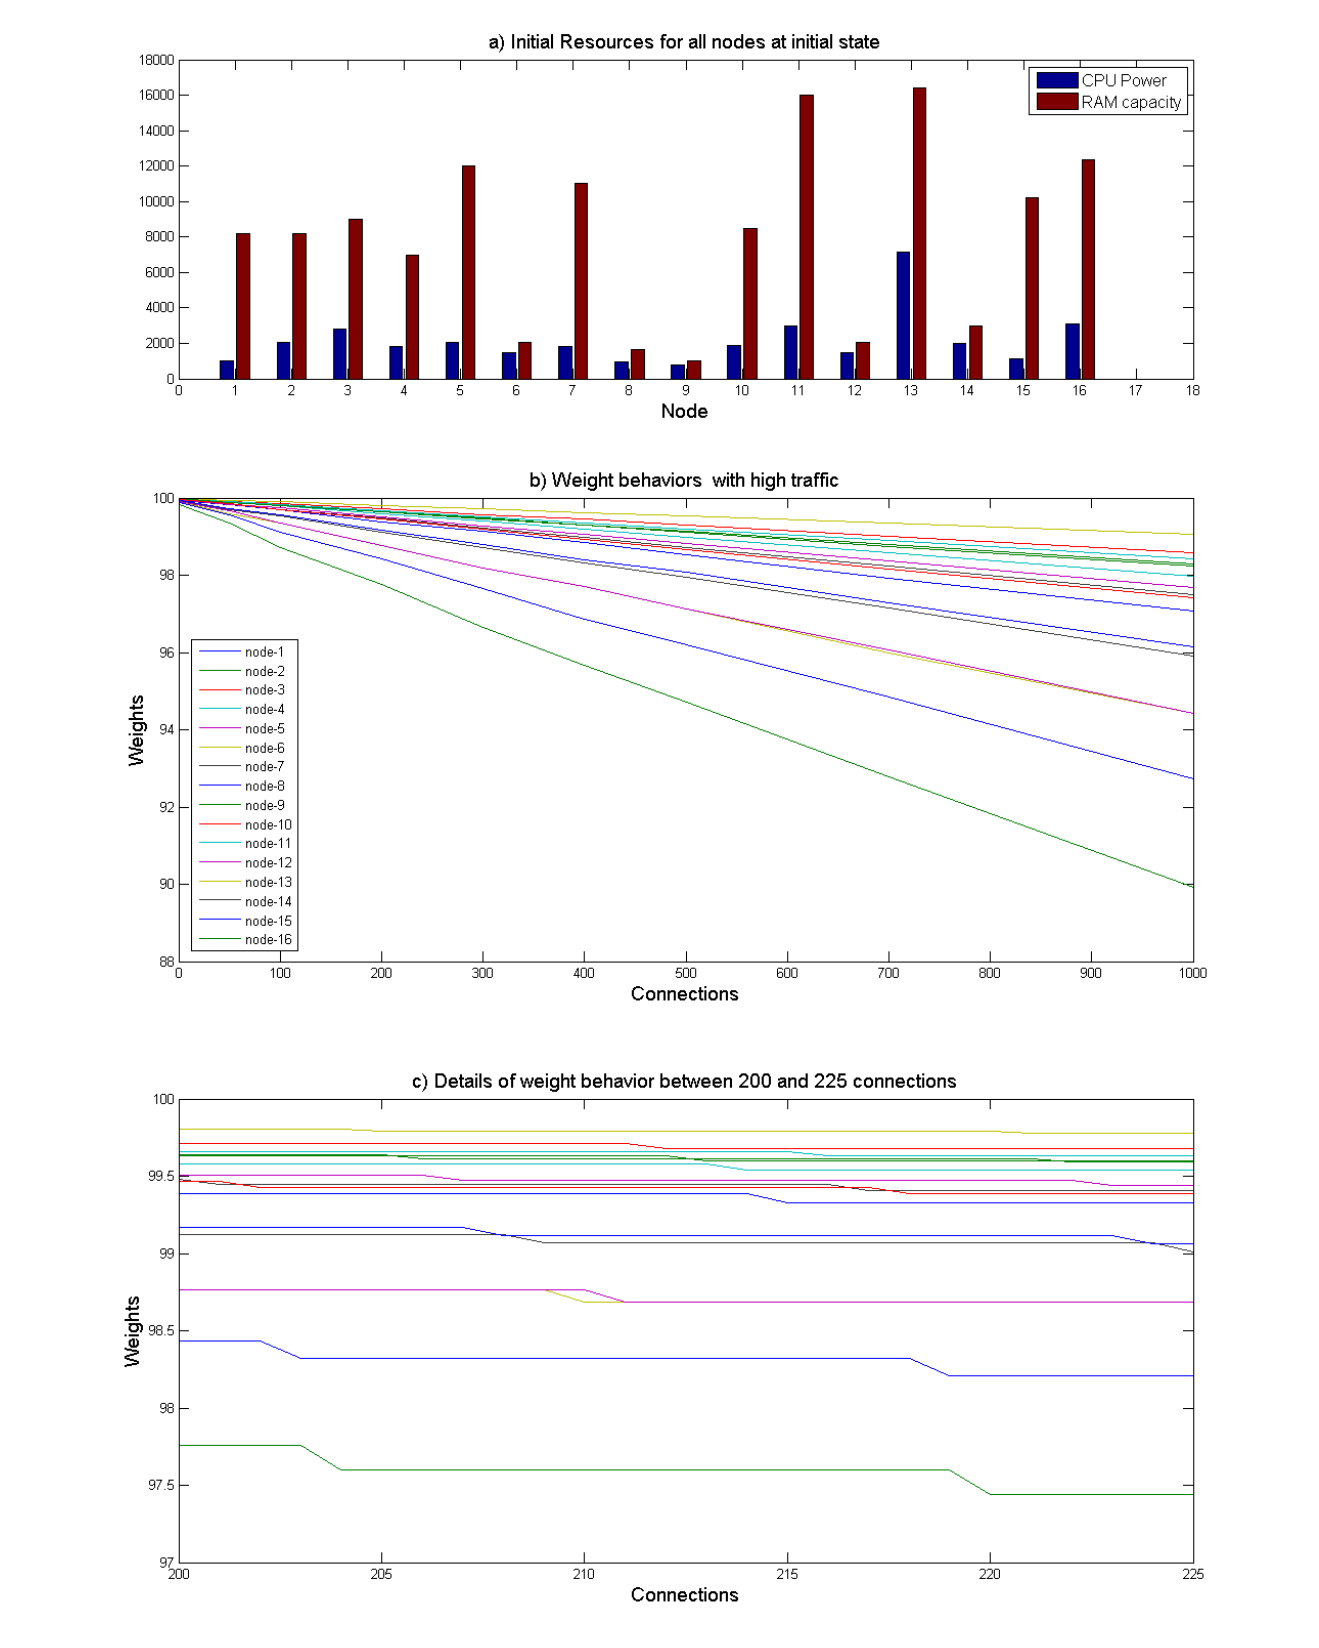
Figure 7. Nodes with different